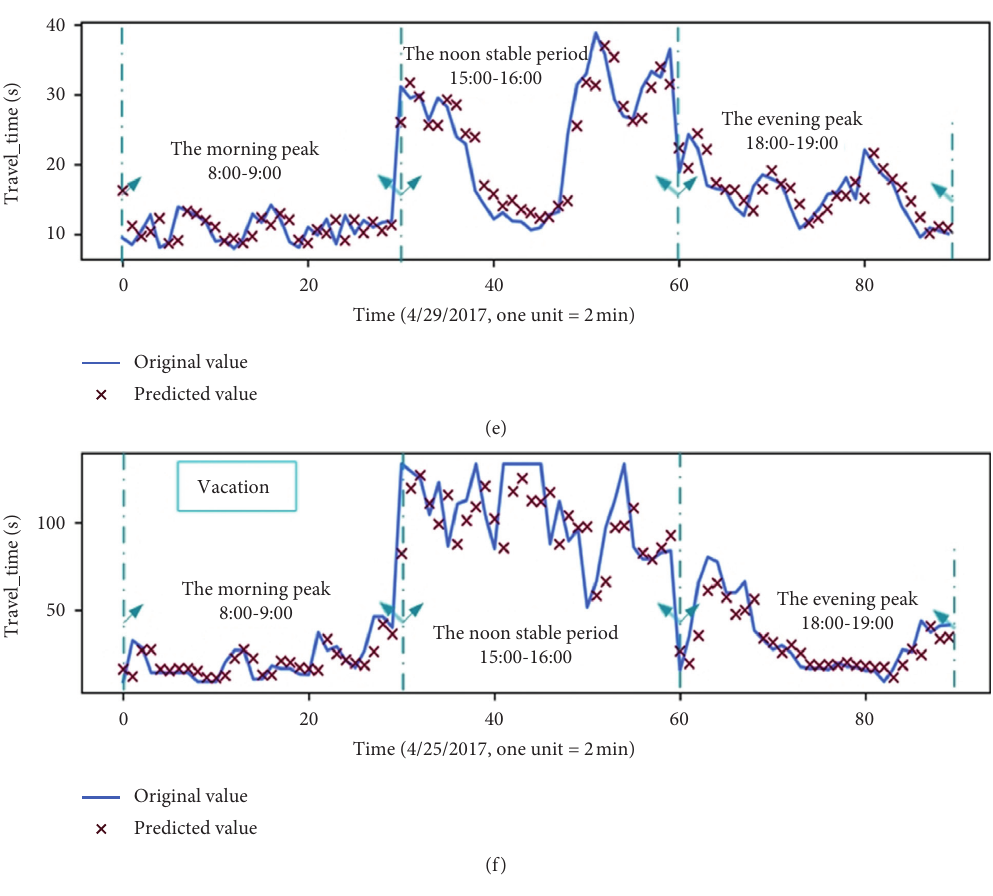
Figure 9: The prediction effect of the EDMCN-XGBoost model. Table 6: Comparison between the forecasting model and baseline model evaluation